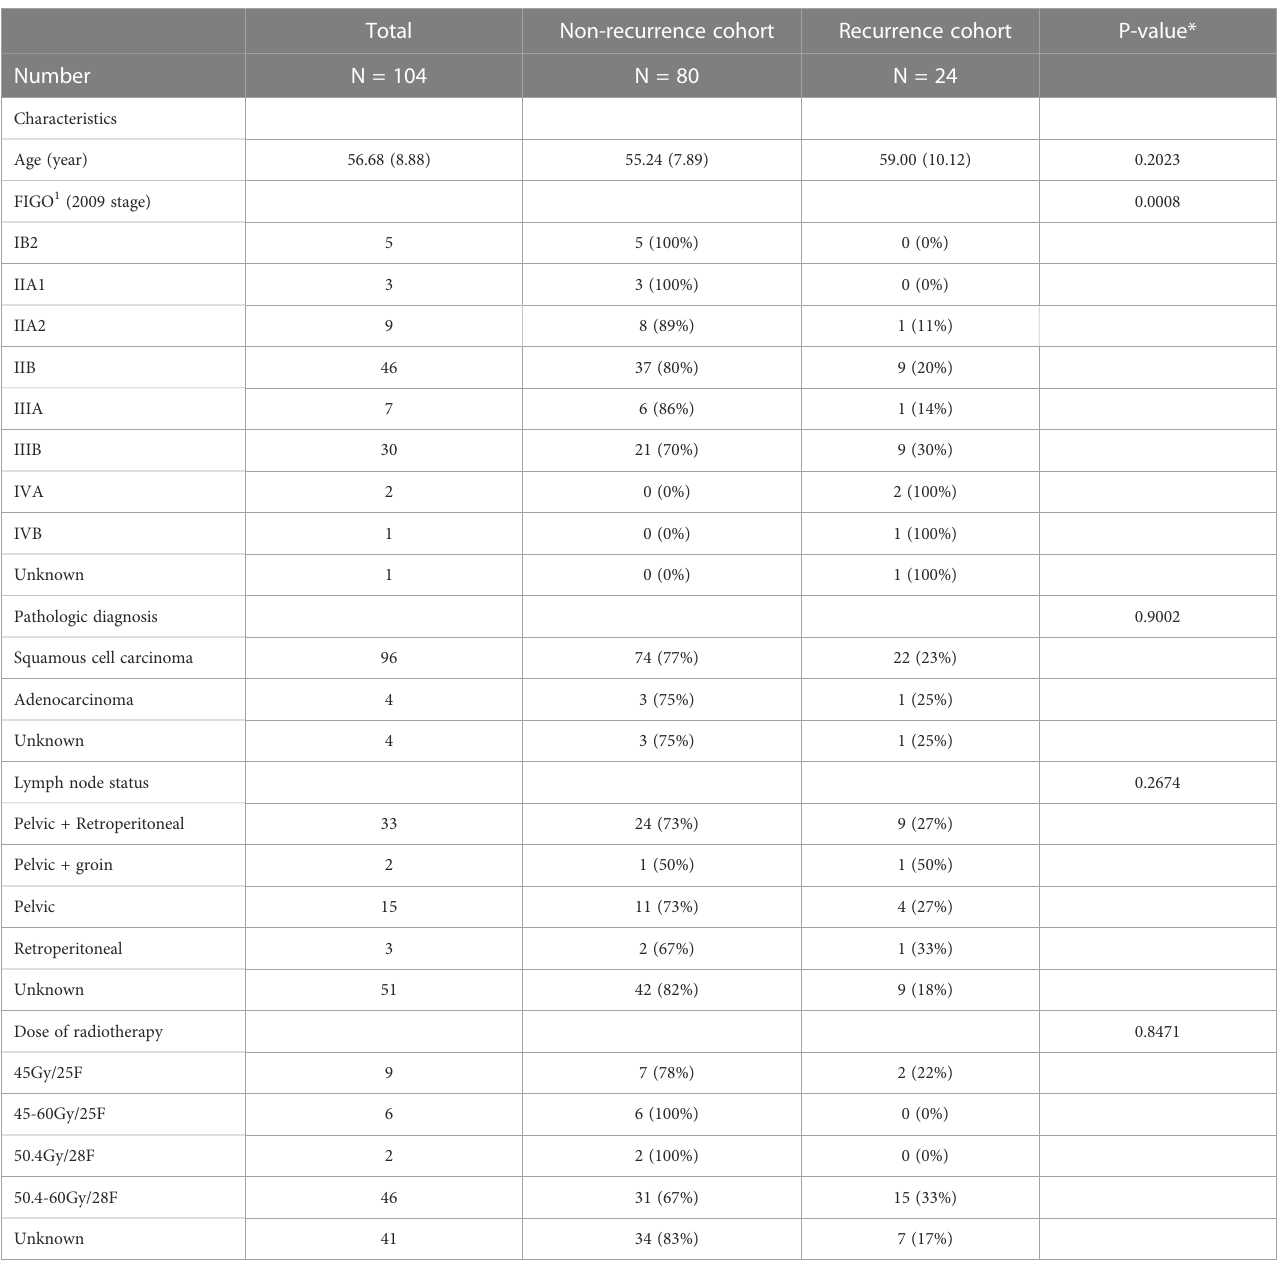
TABLE 1 Clinical characteristics of recurrence and non-recurrence cohorts. Total Non-recurrence cohort Recurrence cohort